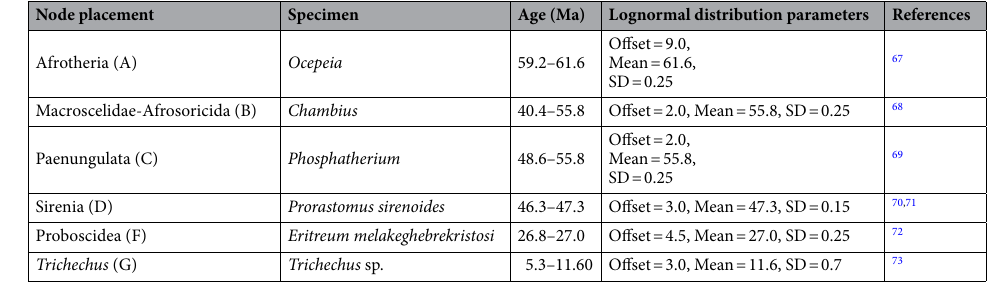
Table 1. Parameters used to calibrate the divergence time analysis, using fossil data on